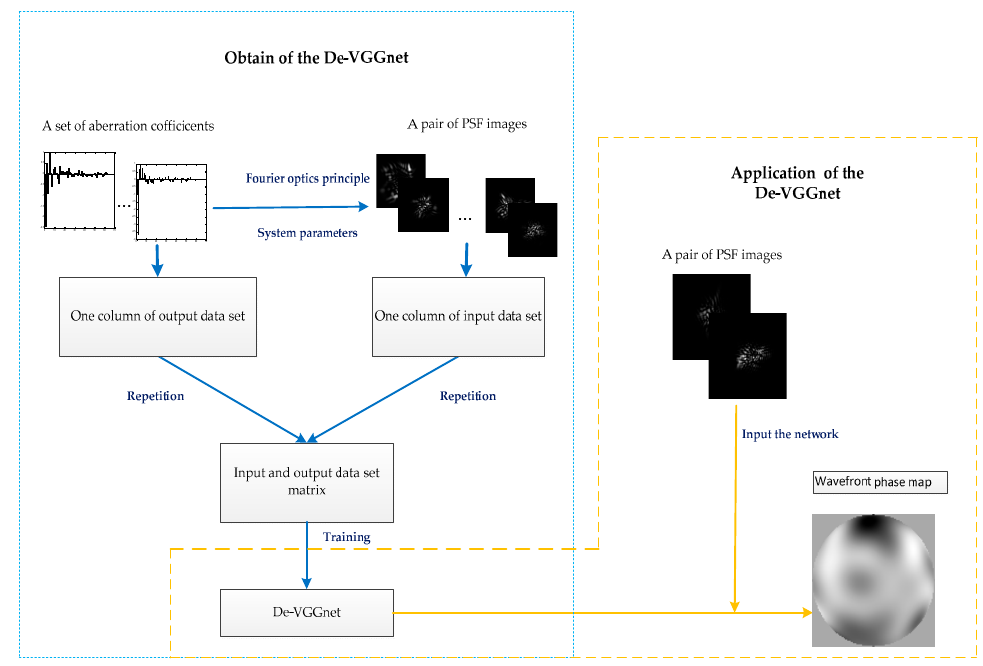
Figure 2. Working procedure of the De-VGG wavefront sensing approach.